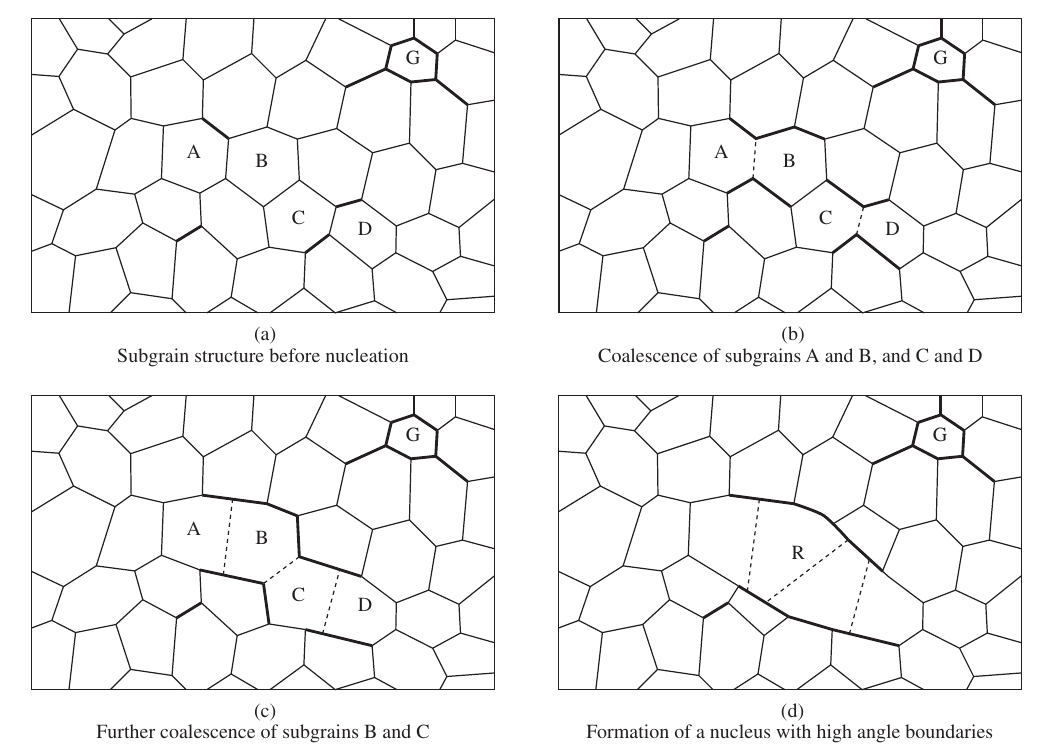
Figure 5. Schematic representation of a recrystallized grain. The orientation difference of subgrains is represented by the line thickness: a) original structure; b) coalescence of pairs by elimination of common boundaries; c) coalescence of the A/B and C/D pairs; and d) recrystallized grain originating from a group of coalesced subgrains. The thicker lines indicate large angle boundaries 36